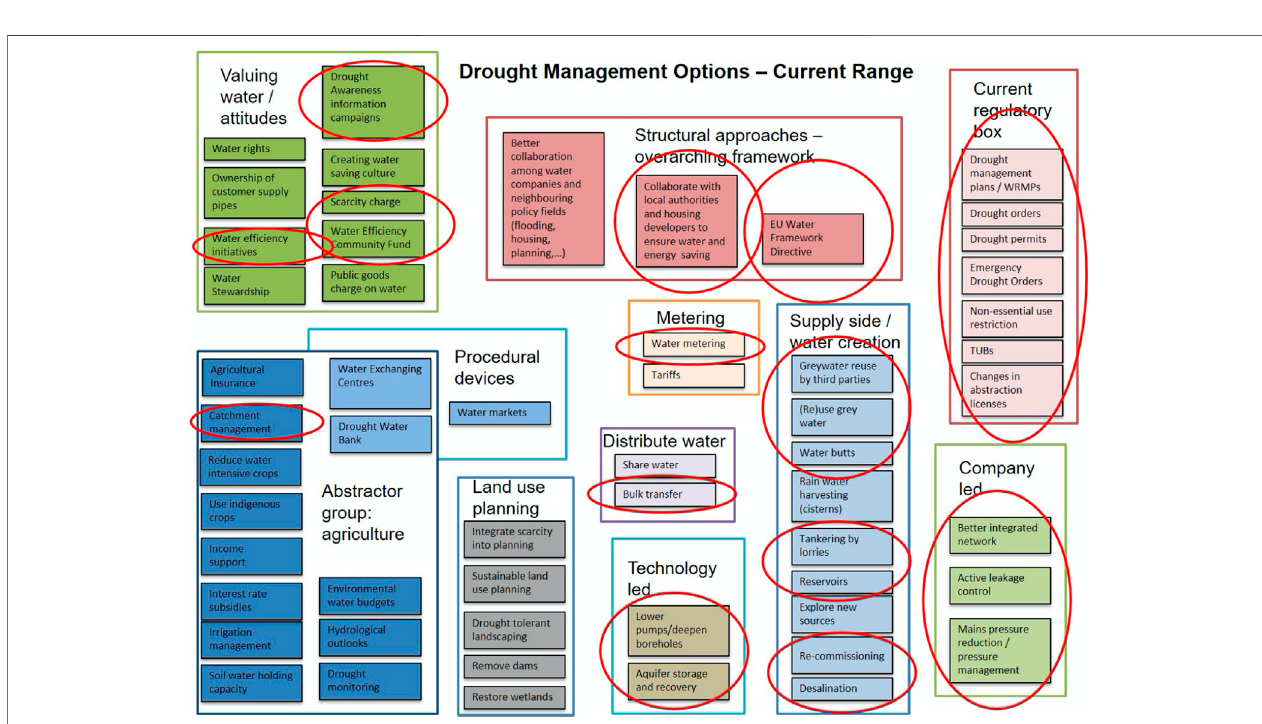
FIGURE 2 | Overview current range of drought and water scarcity management options (circled) [adapted from Grecksch (2021)